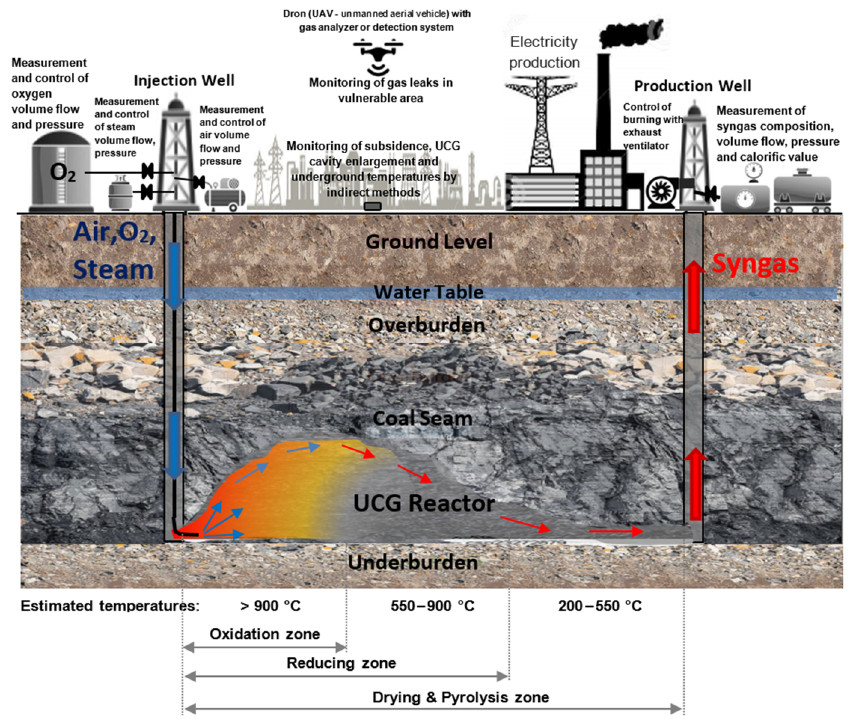
Figure 1. Principle of the UCG process.